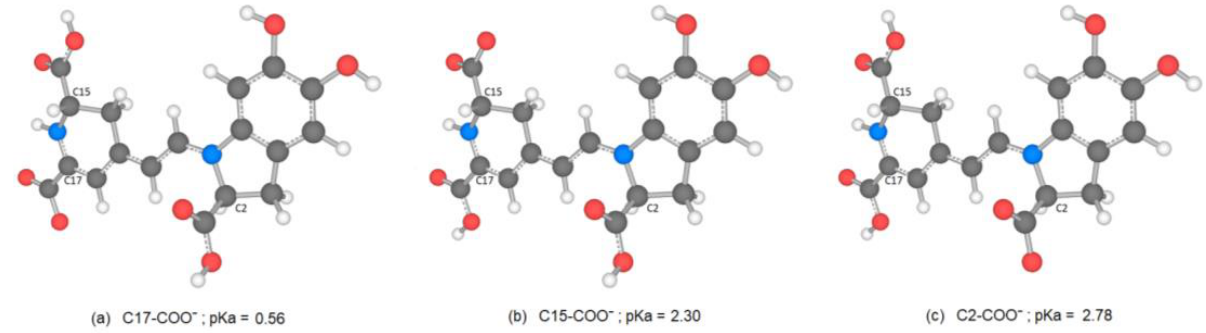
Figure 4. Optimized mono-deprotonated structures (a – c) in the three carboxylic positions and calculated corresponding pK a -values.